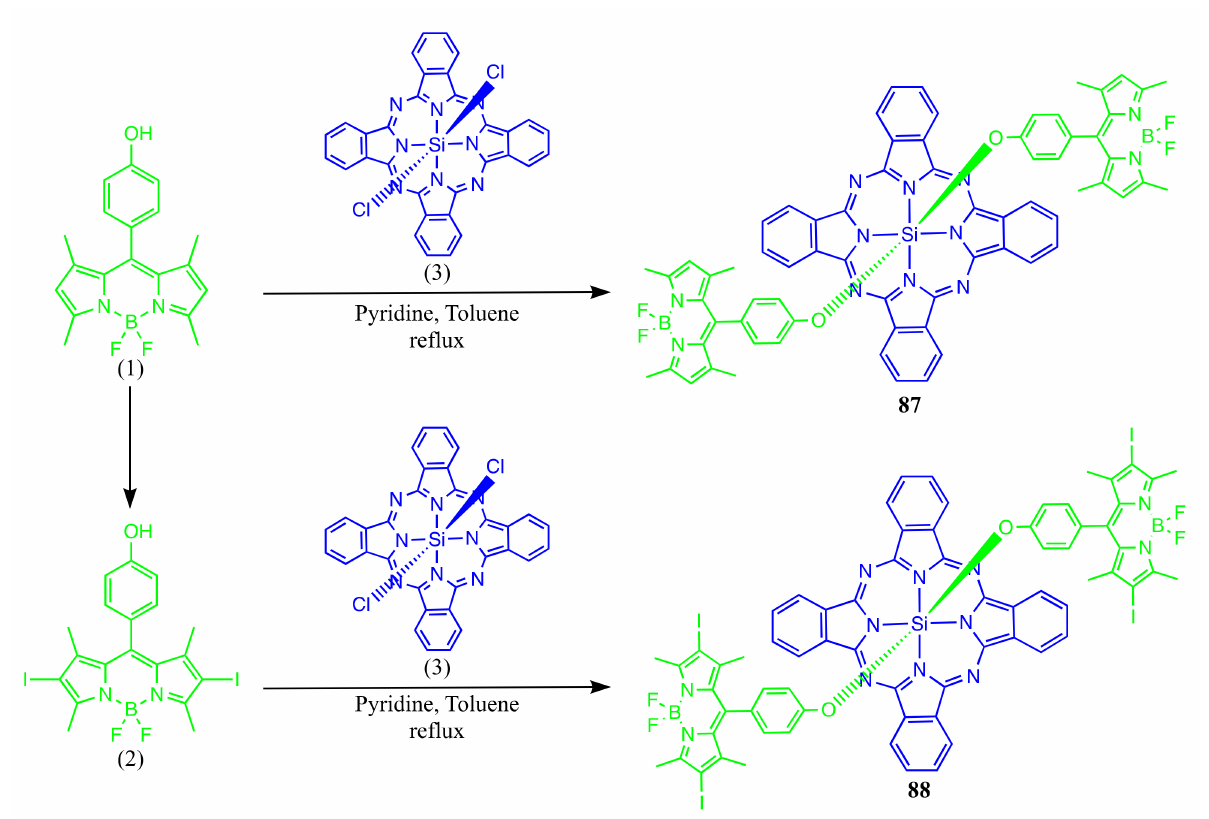
Scheme 45. Structures and synthetic route for compounds 87 and 88 .